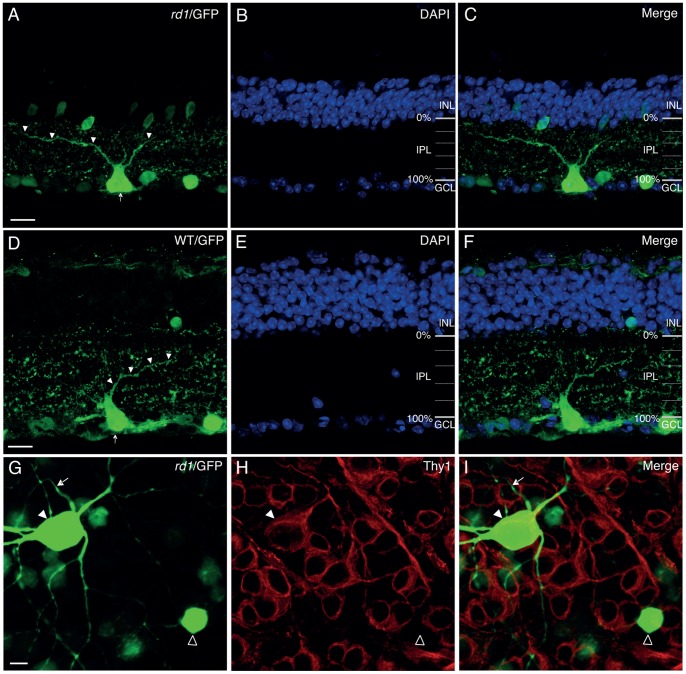
Determining the dendritic stratification level of RGCs in the IPL.
A, One representative image of AAV-GFP transduced RGCs in a cross section of rd1 retinas. In this illustration, the RGC has a big soma (arrow) and a broad dendritic tree (arrowheads). B, To define the stratification level of RGC dendrites in the IPL, we stained cell nuclei with diamidinophenylindole (DAPI). The INL and GCL delineate the proximal (0%) and distal (100%) boundaries of the IPL, respectively. C, Merged image shows that the dendrite of the RGC are centered at 25% of the IPL. D–F, One representative image of AAV-GFP transduced RGCs in a cross section of WT mouse retinas was shown as comparison. The transfection in WT was similar to what we observed in rd1 mice. G–I, To distinguish RGCs from diaplaced amacrine cells, AAV-GFP transduced retinas were co-labeled with an antiserum against Thy-1, a marker for all RGCs. Single image section was taken from the ganglion cell layer with focus on cell bodies, and the axon of one AAV-GFP transduced cell was out of focus (arrow). The transduced cell with an axon colocalized with Thy-1 (solid arrowhead), while another transduced cell without an axon did not colocalize with Thy-1 (open arrowhead). INL, inner nuclear layer; IPL, inner plexiform layer; GCL, ganglion cell layer. Scale bars, 20 µm in A–F, and 10 µm in G–I.